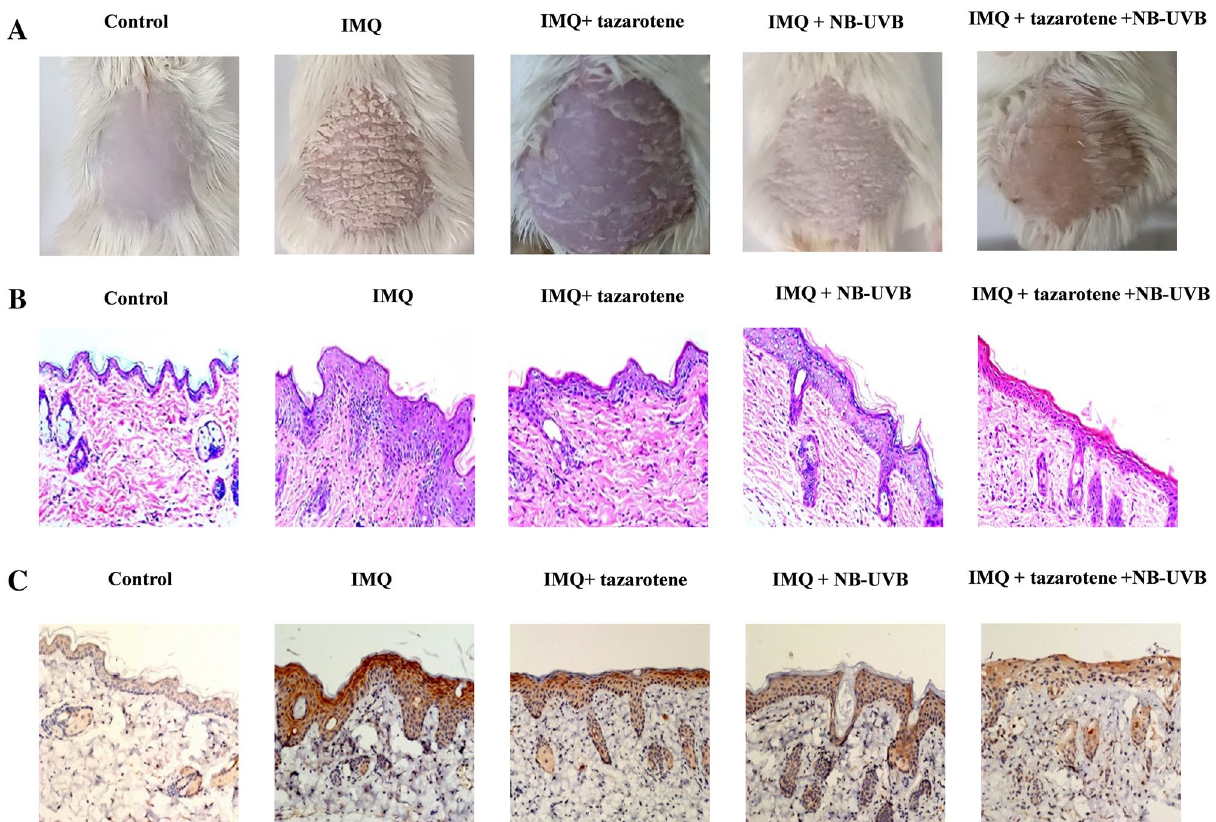
Figure 2. Effects of pharmacological treatment and NBUVB irradiation on pathological changes in psoriatic mice. ( A ) Representative photographs showing skin lesions of mice after indicated treatments. ( B ) Pathological changes in skin tissues from mice in treated as in ( A ). Representative HE staining images are shown (×200). ( C ) Histochemical analysis of MMP13 expression in skin tissues from mice with indicated treatments. Representative images of MMP13 staining are shown